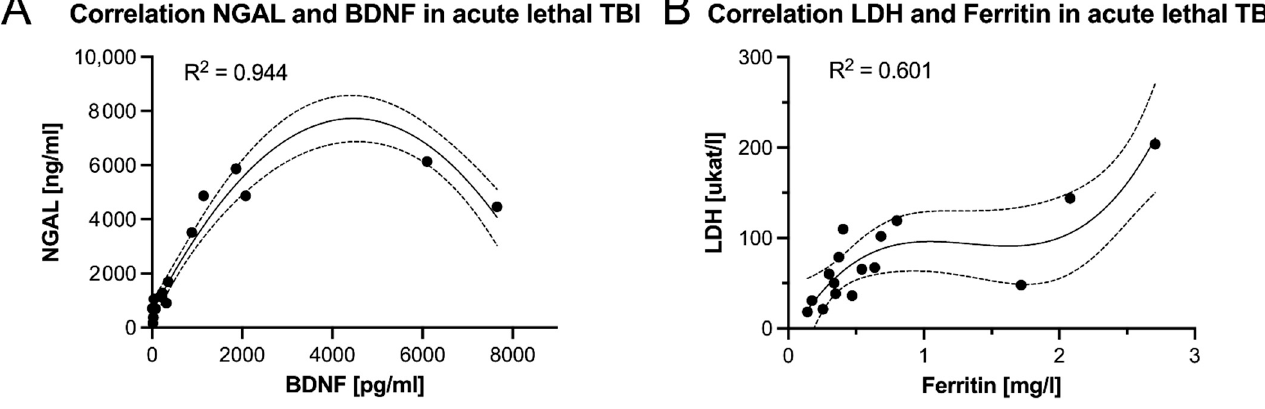
Figure 5. A polynomial regression analysis revealed ( A ) a strong correlation between neutrophil gelatinase-associated lipocalin (NGAL) and brain-derived neurotrophic factor (BDNF), and ( B ) a moderate correlation between lactate dehydro- genase (LDH) and ferritin in acute lethal traumatic brain injuries (TBI) using post mortem cerebrospinal fluid biochem- istry.